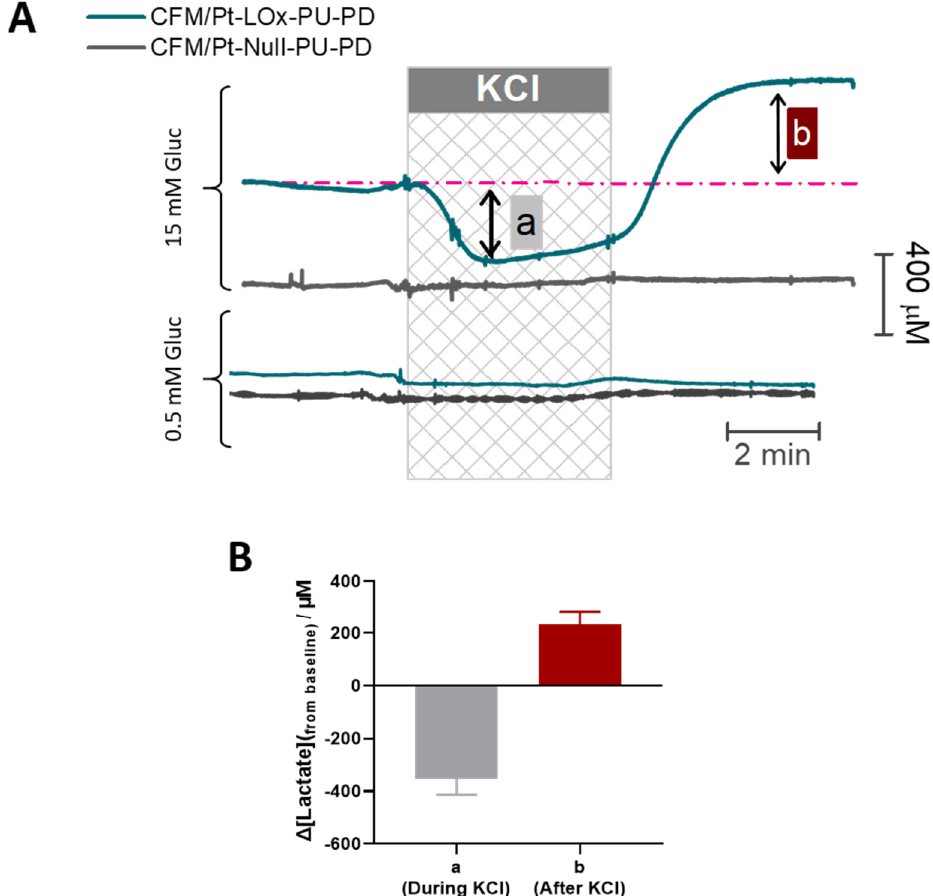
Figure 6. ( A ) Representative recording of extracellular lactate in the CA1 subregion of hippocampal slices upon stimulation with KCl (checkered box, 60 mM, 5 min). The top panel shows a response observed when high glucose (15 mM) is present in the perfusion media while the bottom panel shows a response observed when glucose concentration in perfusion media is low (0.5 mM). ( B ) The plot of the average change in lactate concentration measured in phases a (during KCl stimulation) and b (after KCl stimulation) of each recording.